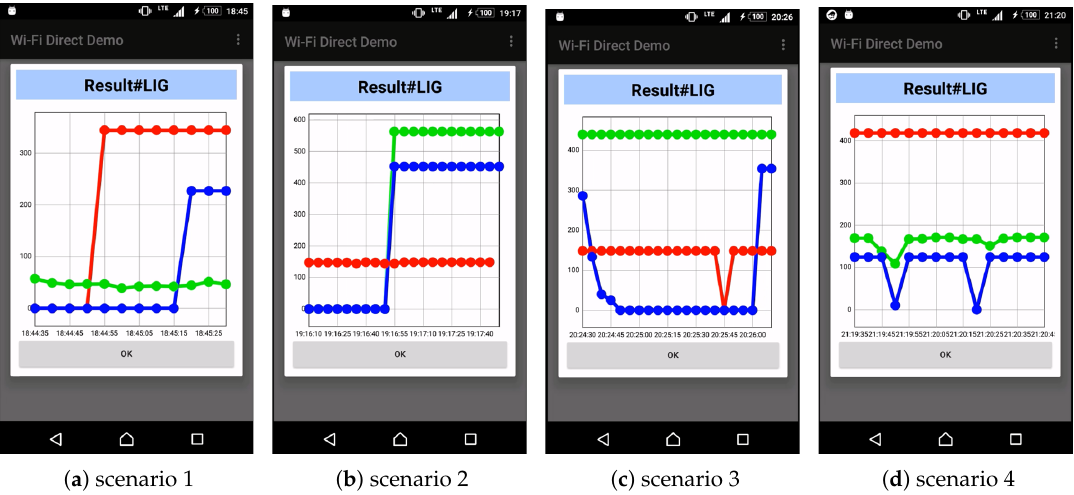
Figure 9. Operation verification results. The X-axis represents the time when messages arrived, and the Y-axis represents the acquired illuminance sensor value (lux). The color of the graph corresponds to the character color of the device number in Figure